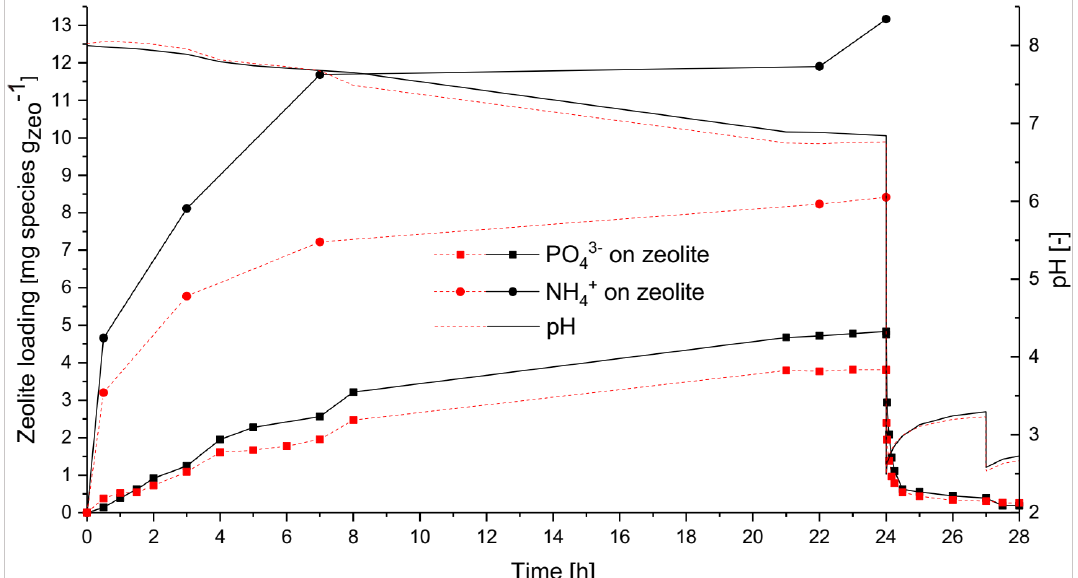
Figure 2. Effect of initial ammonium concentration at pH = 8 on P-removal. Initial values of experiments: black solid lines: